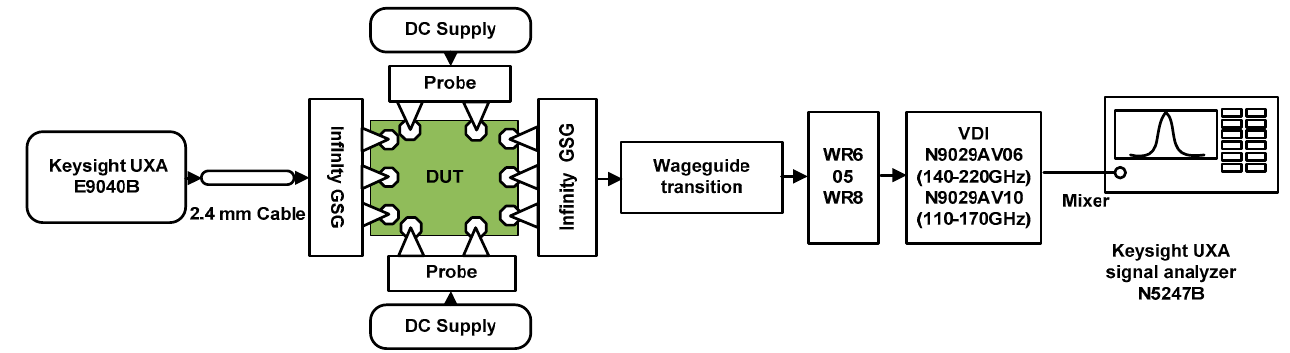
Figure 11. The measurement diagram of the proposed chip.